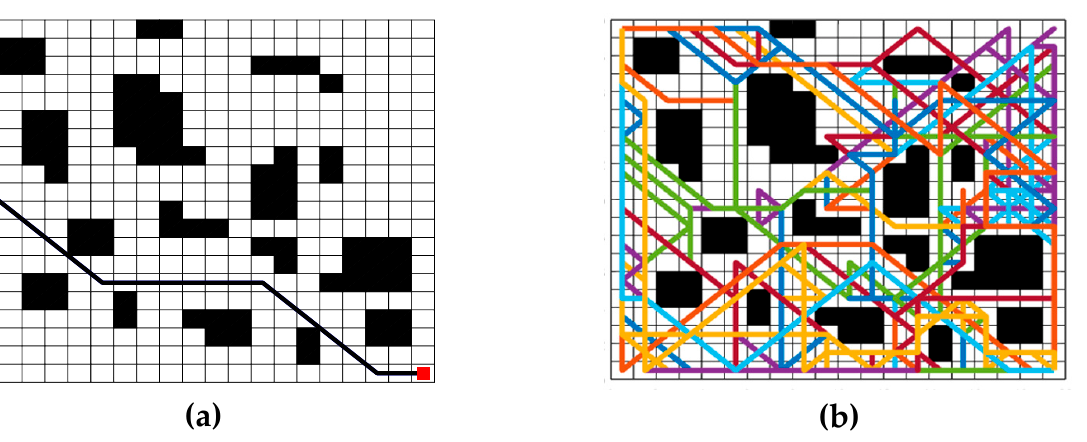
Figure 12. Diagram of the optimal path of this paper; ( a ) Optimal path diagram; ( b ) All ants’ paths diagram.